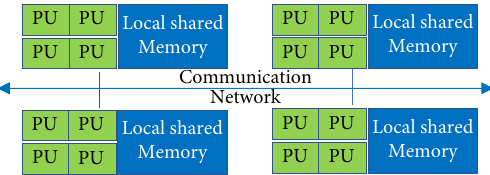
Fig. 5 Hybrid memory